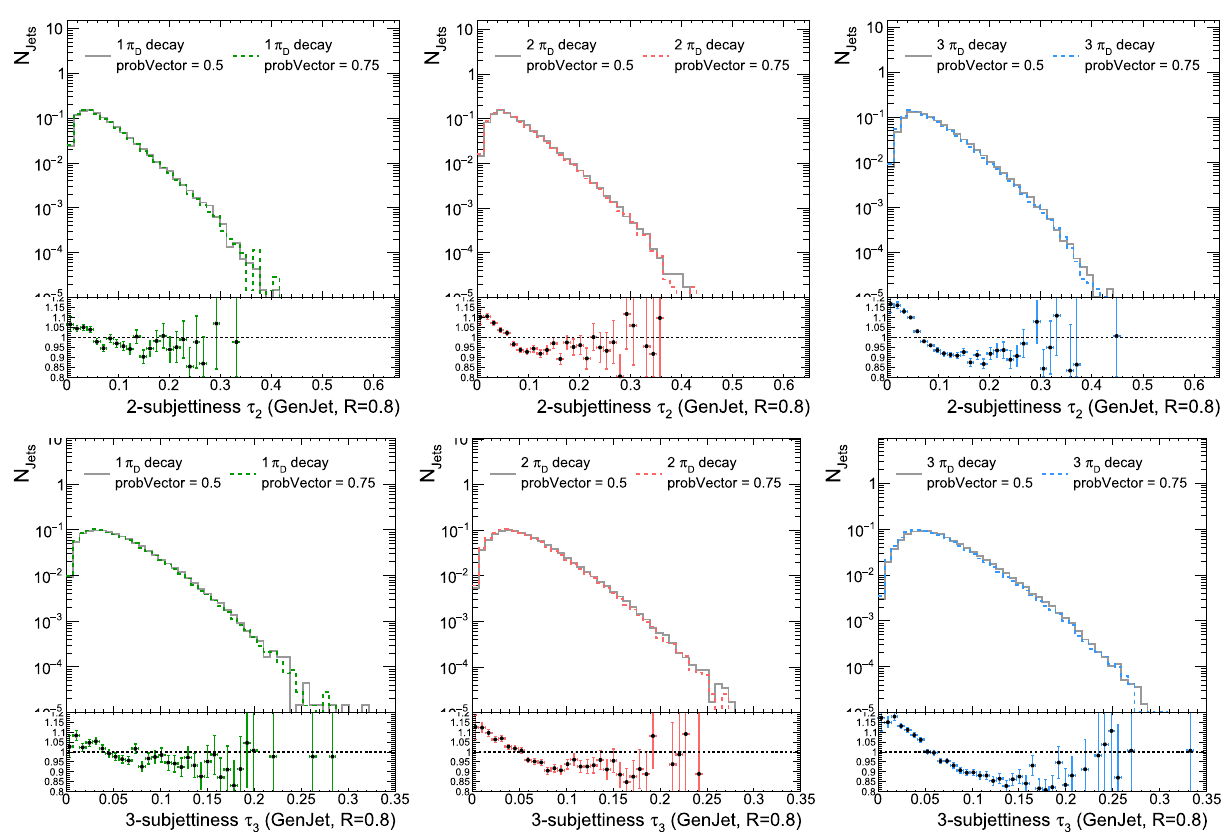
Fig. 42 Comparison of N -subjettiness between probVector=0.5 (grey solid line) and probVector=0.75 (colored dashed line). The com- parison is made for 1 (left), 2 (middle) and 3 (right) dark pions decay. The plotted ratio is the ratio of probVector=0.75 to probVector=0.5